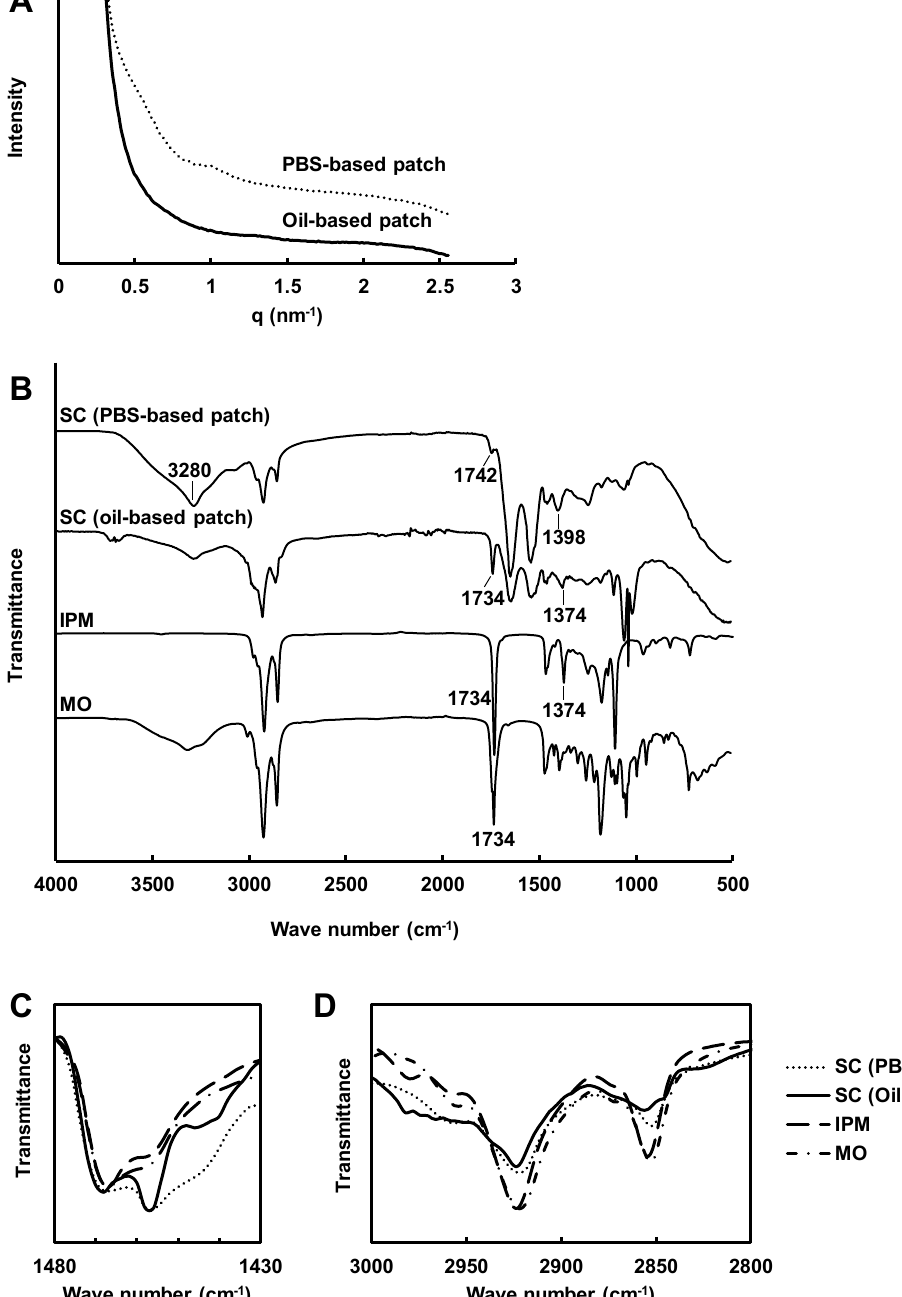
Figure 4. Structural analysis of stratum corneum (SC) treated with a PBS-based ovalbumin (OVA) patch, and an oil-based OVA patch for 24 h at 32 °C ( n = 4). ( A ) Small-angle X-ray scattering patterns of SC samples. ( B – D ) Attenuated total reflection infrared spectra of SC samples, isopropyl myristate (IPM), and monoolein (MO) from 500 cm − 1 to 4000 cm − 1 ( B ), the CH 2 bending region derived from ceramides ( C ), and the CH 2 symmetric and asymmetric stretching regions ( D ).